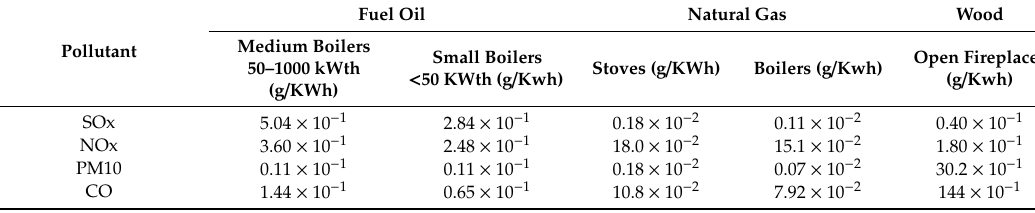
Table 2. Emission factors for residential heating by technology and fuel used